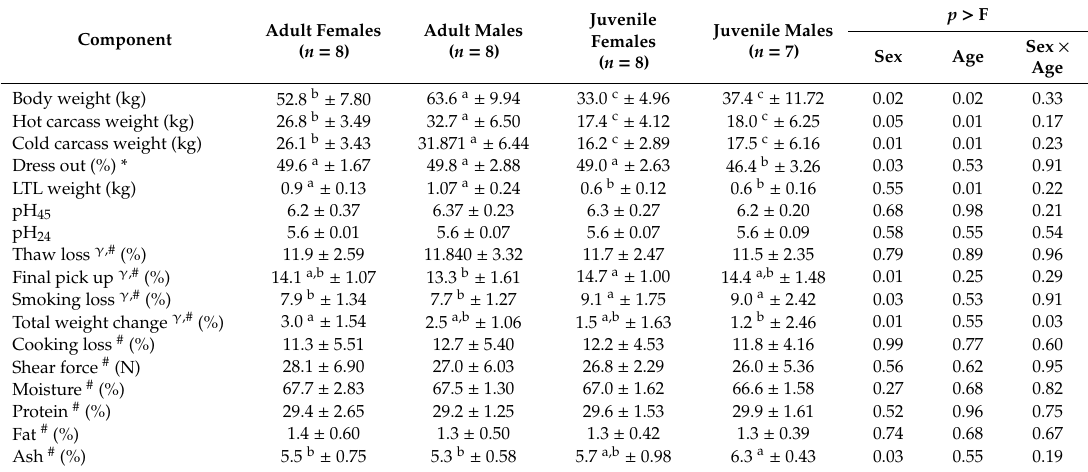
Table 4. The average values ( ± SD) of the physical measurements of warthog carcasses and chemical composition of back bacon ( Longissimus thoracis) according to sex and